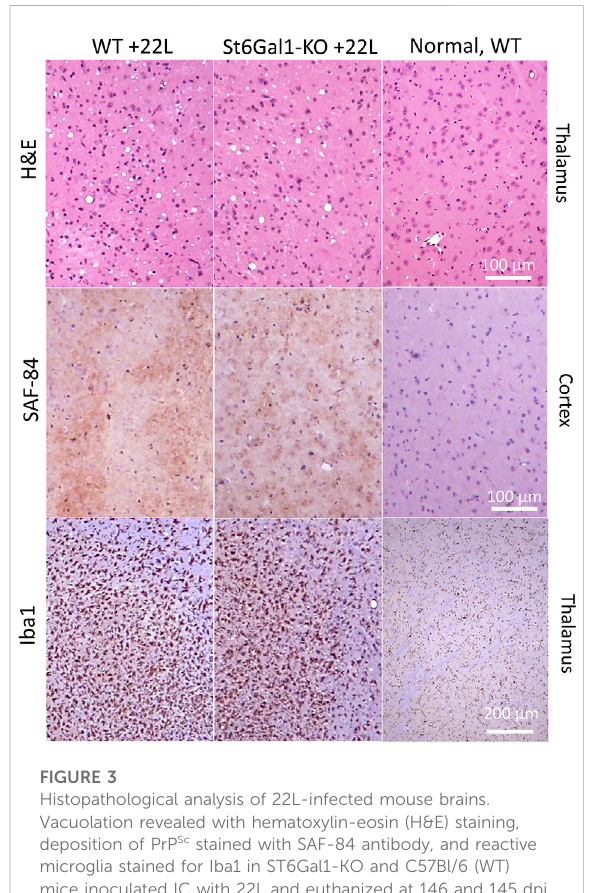
FIGURE 3 Histopathological analysis of 22L-infected mouse brains. respectively. Staining of normal C57Bl/6 (WT) euthanized at 212 days of age is shown as references (right panels).